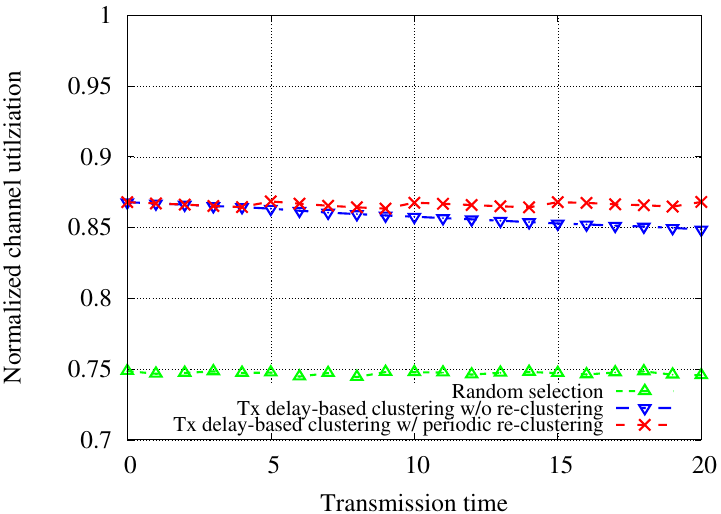
Figure 2. Normalized channel use (packet arrival rate and transmission rate are same). There are 16 non-AP stations.